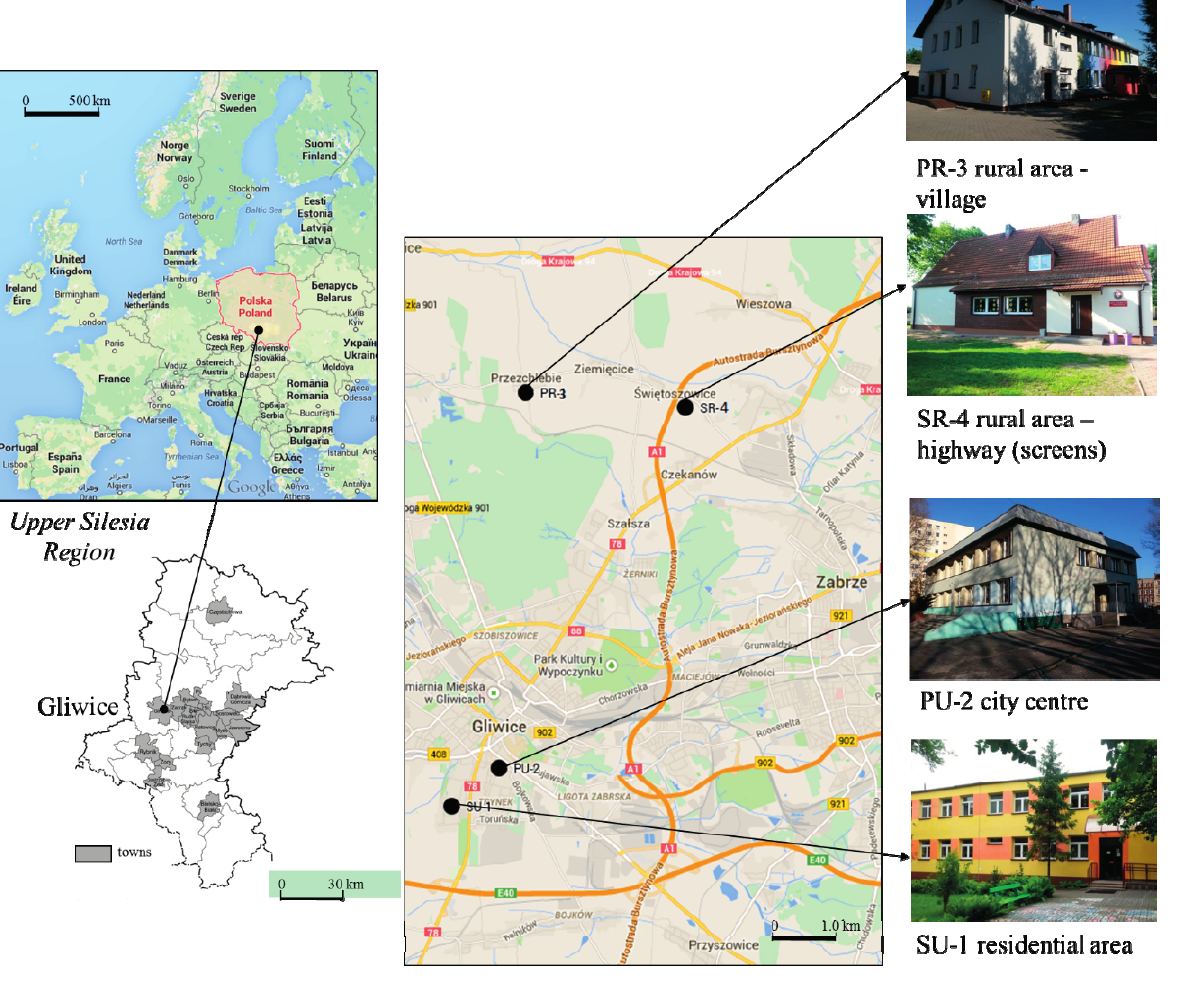
Figure 1. Localization of the investigated nursery schools (Map data: 2015 © Google,